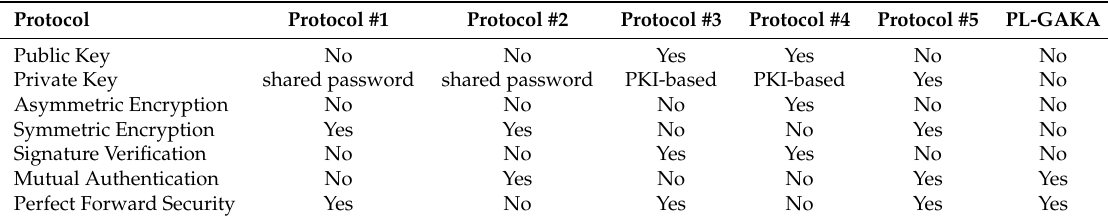
Table 2. The overall comparison between the proposed solution and related